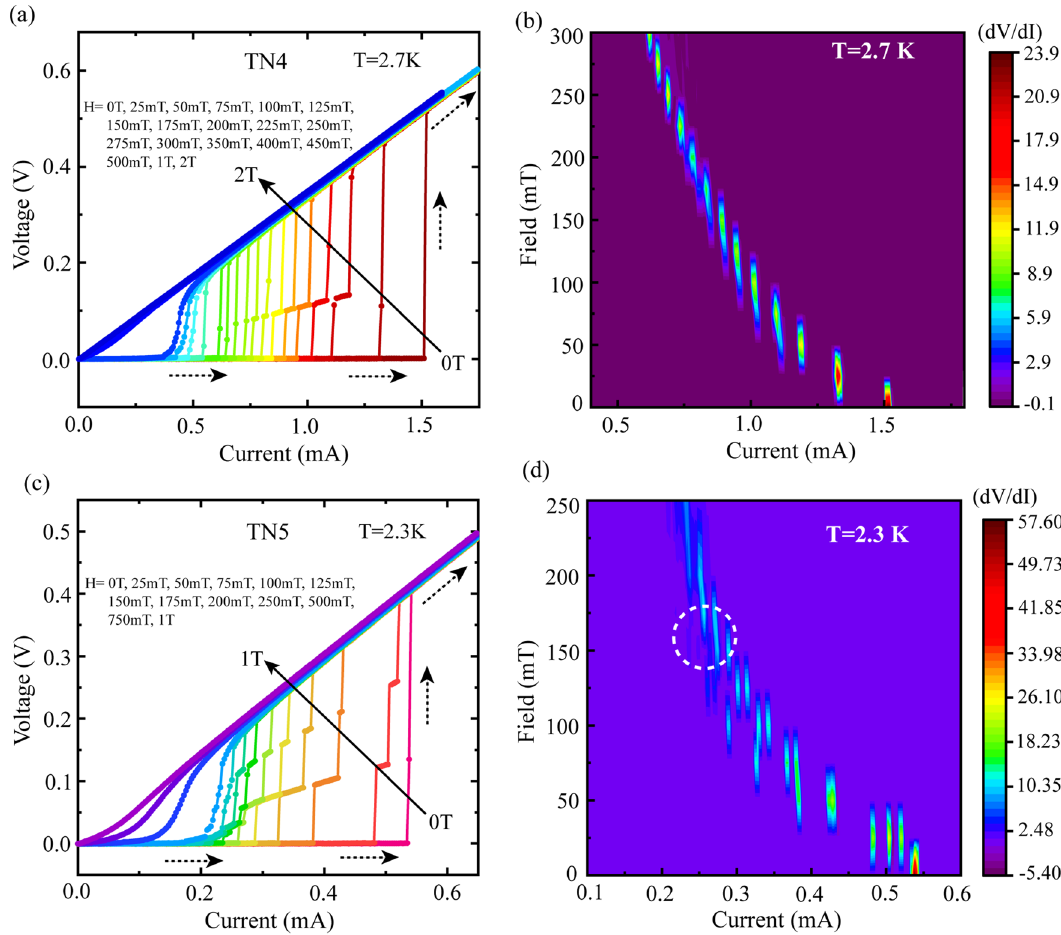
Figure 5. Magnetic field dependence of IVCs for samples TN4 (~ 4 nm) and TN5 (~ 3 nm) that are annealed at 820 °C. ( a ) Field-dependent IVCs for sample TN4 measured at fixed temperature 2.7 K and ( b ) corresponding dV/dI with respect to field & current in 3-D colour plot. ( c ) Variation of IVCs with magnetic field but at fixed temperature 2.3 K for sample TN5 and ( d ) the related dV/dI with respect to field & current in 3-D representation using contour colour plot. The Black solid arrows and dotted arrows in ( a , c ) indicate the increasing direction of applied magnetic field and the current sweeping direction,